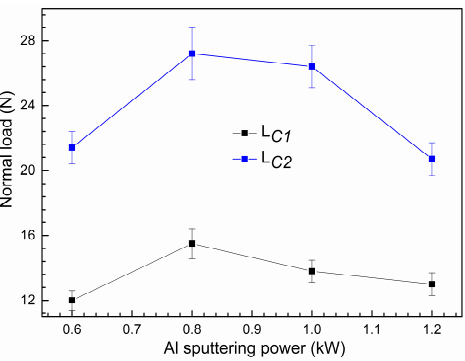
Figure 9. Critical load ( L C1 and L C2 ) values of the four CrAlSiN coatings deposited under different Al sputtering power.